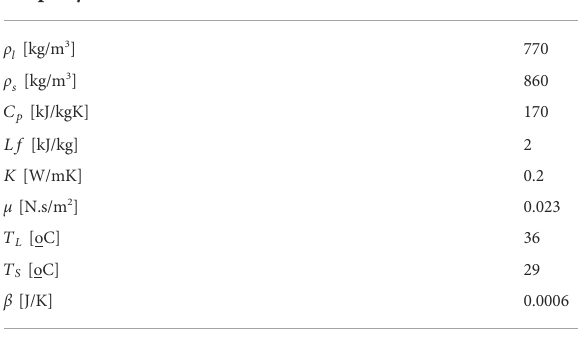
TABLE 1 Thermodynamic properties of the PCM used in this study (Najim et al., 2022b). Property